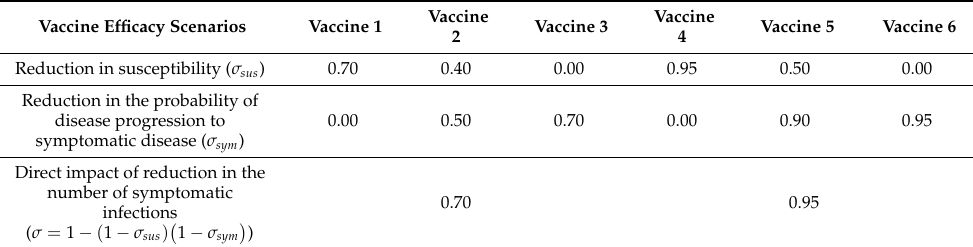
Table 3. Vaccine efficacy scenarios used in the main